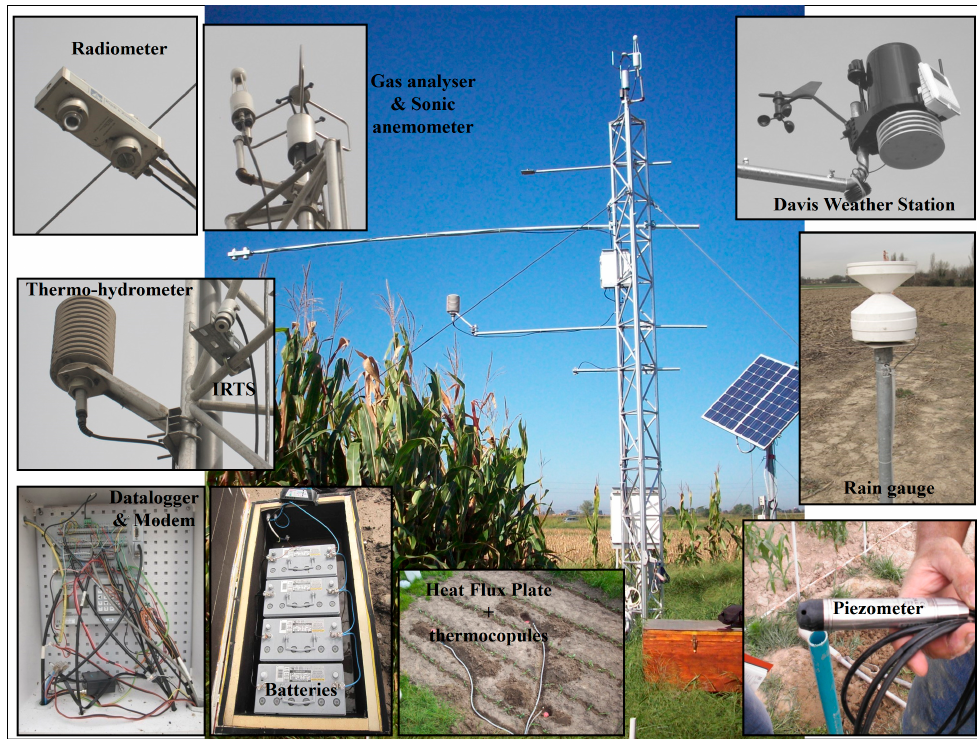
Figure 1 . Instrumentation of the study site of Livraga. Figure 1. Instrumentation of the study site of